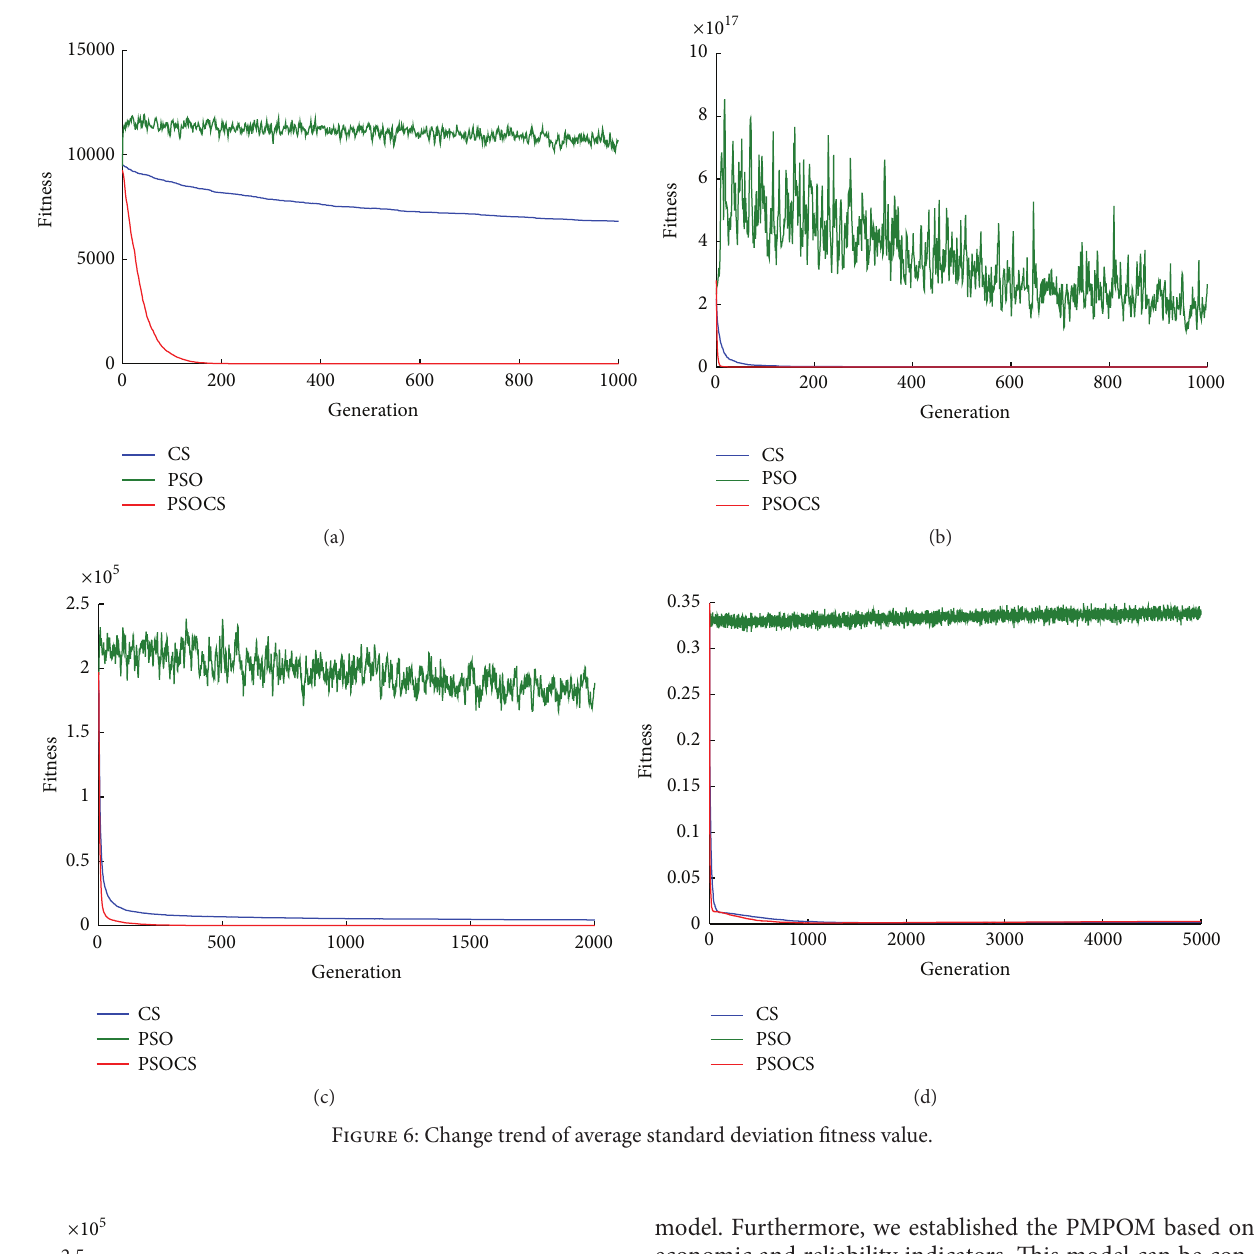
Figure 6: Change trend of average standard deviation fitness value.